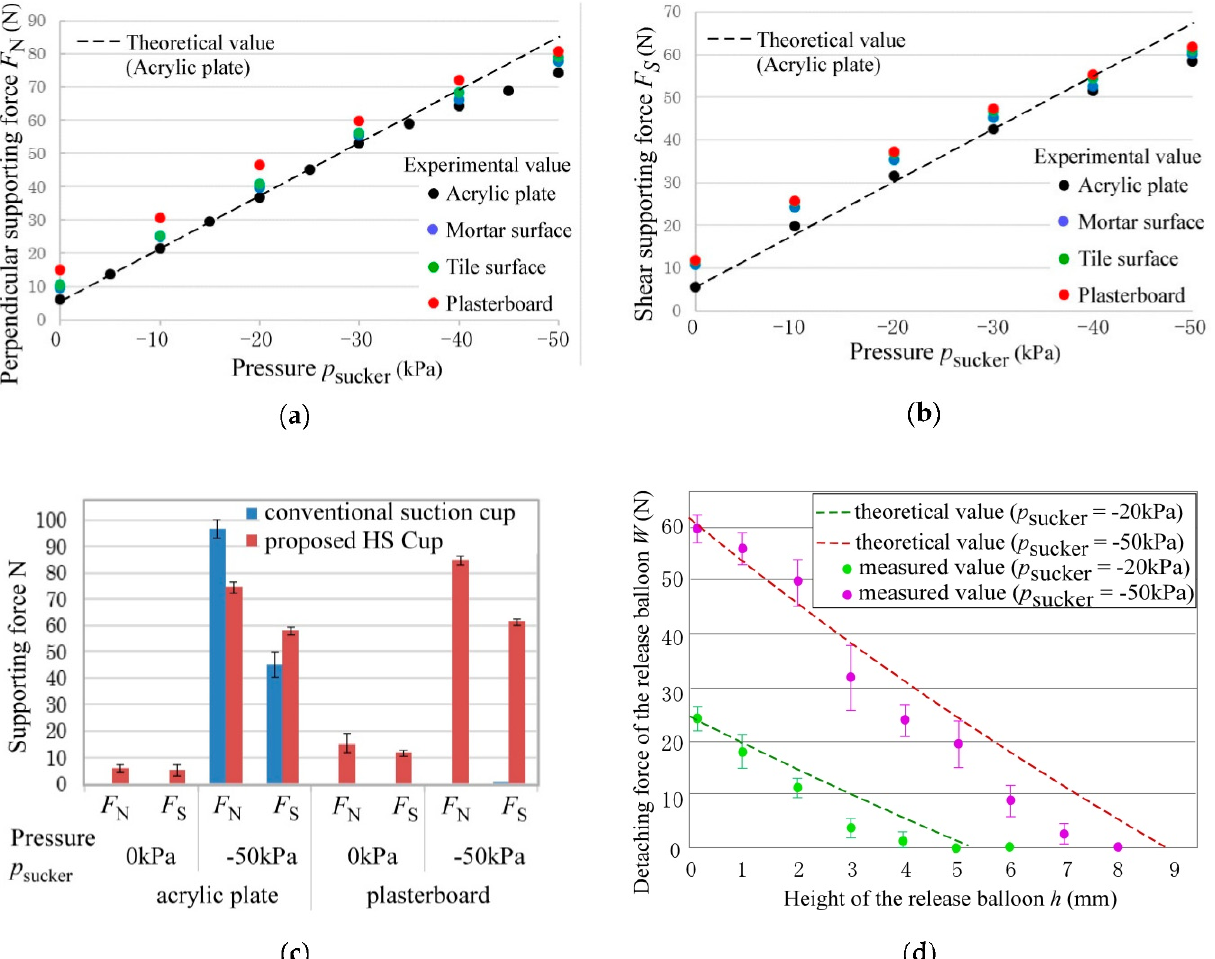
Figure 7. Comparison of experimental and theoretical values of the prototype: ( a ) perpendicular supporting force on 4 types